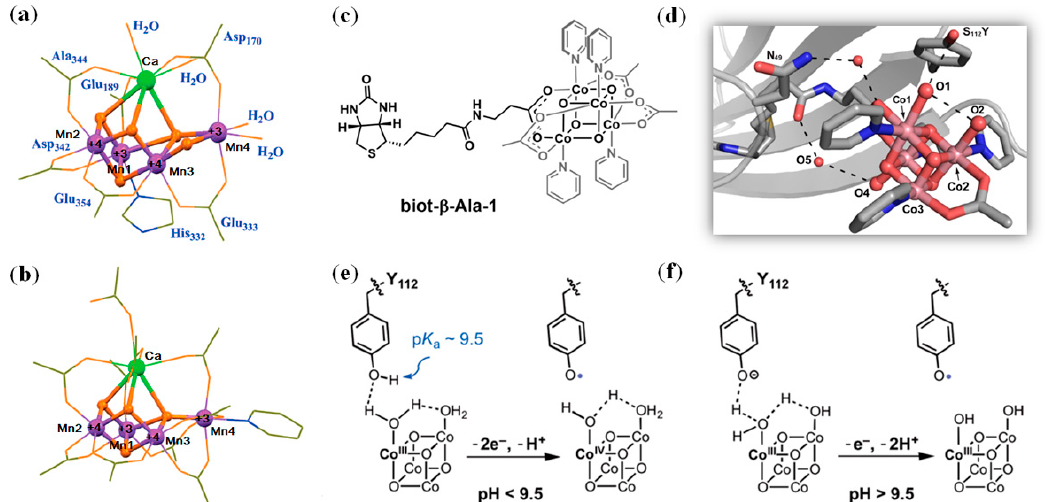
Figure 9. ( a ) The X-ray crystal structure of native oxygen-evolving center (OEC) showing the core Mn 4 CaO 5 cluster and the ligands; ( b ) The X-ray crystal structure of a synthesized Mn 4 CaO 4 cluster; Reprinted with permission from [121], Copyright 2015 AAAS; ( c ) The chemical structure of biotinylated Co 4 O 4 cluster, biot- β -Ala-1; ( d ) The X-ray crystal structure of 2xm-S112Y-Sav with biot- β -Ala-1 bound (PDB code 6AUE); ( e – f ) Proposed mechanisms for the multi-e − / multi-H + reactivity of the designed enzyme at pH < 9.5 or pH > 9.5.Reprinted with permission from [123]. Copyright 2018 American Chemical Society.